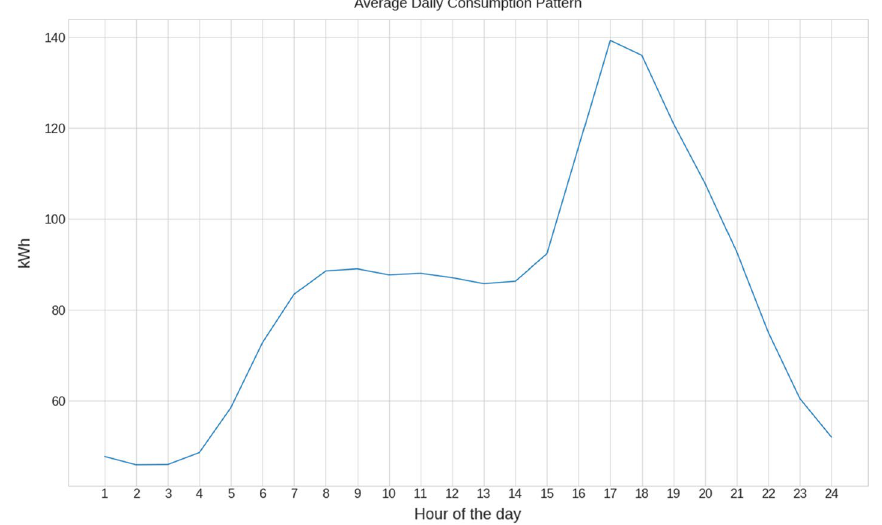
Fig. 4 Average daily load profile of the aggregated